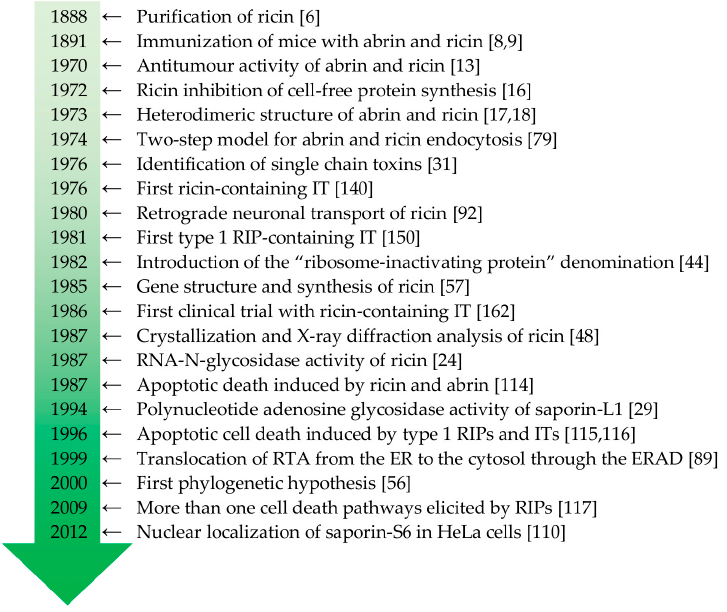
Figure 1. Timeline of milestones in RIP research. ER: endoplasmic reticulum; ERAD: endoplasmic reticulum-associated protein degradation; IT: immunotoxin; RIP: ribosome-inactivating protein; RTA: ricin toxin A-chain.